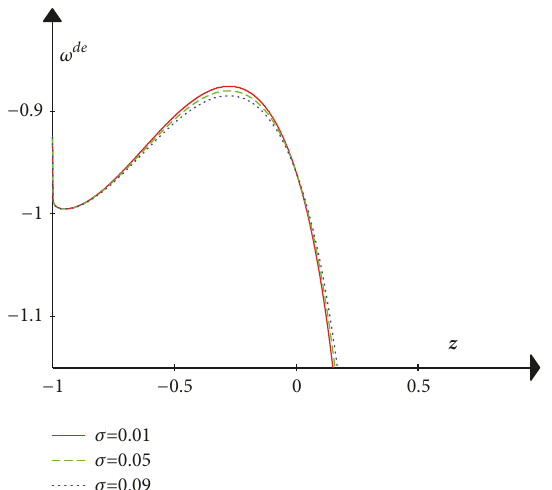
Figure 3: The plot of EoS parameter 𝜔 𝑑𝑒 versus redshift 𝑧 for 𝛼 = 1, 𝛽 = 0.01 , Ω 𝑚 = 0.3, 𝜔 𝑚 = 0, 𝜔 = 2 , and vary 𝐾 = 0.01 , 0.05, 0 0.09, resp. Figure 4: The plot of total energy densities versus redshift 𝑧 for 𝛼 =